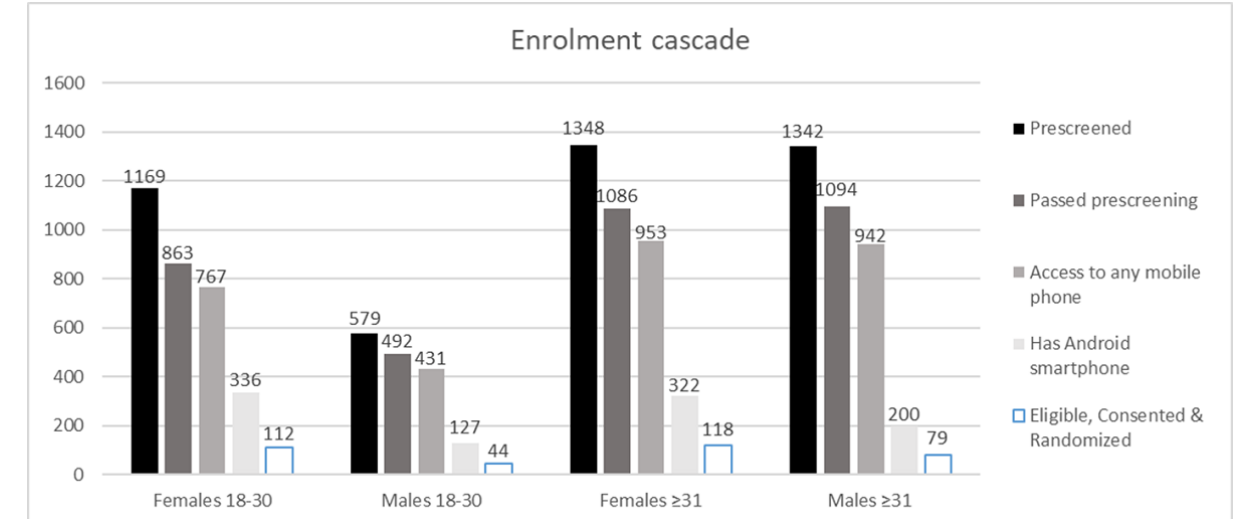
Figure 3. Enrolment cascade (number of